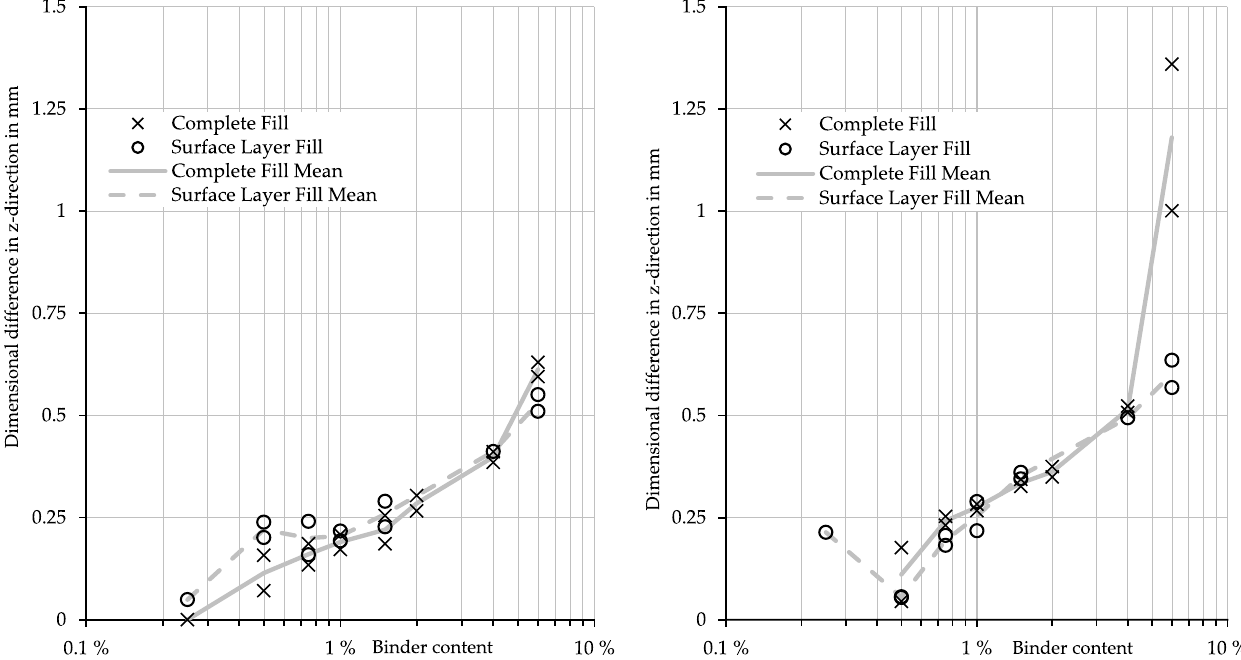
Figure 10. Influence of the binder content on the geometric difference between the nominal and actual dimension in the z-direction ( left: upskin, right: